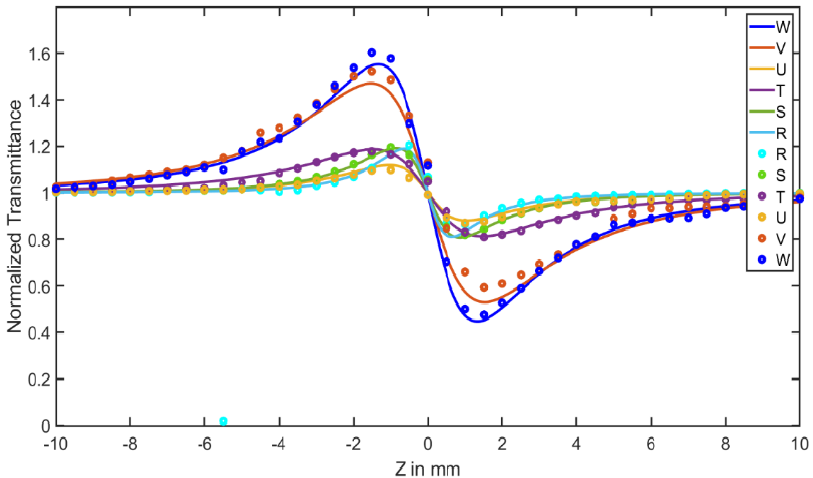
Figure 9. Pure nonlinear curves for the samples: R (Ag), W (Al 2 O 3 ), V (Al 2 O 3 /PVA film), S (Ag/PVA film), T (Ag/Al 2 O 3 /PVA1 film), U (Ag/Al 2 O 3 /PVA2 film). film), T (Ag/Al 2 O 3 /PVA1 film), U (Ag/Al 2 O 3 /PVA2